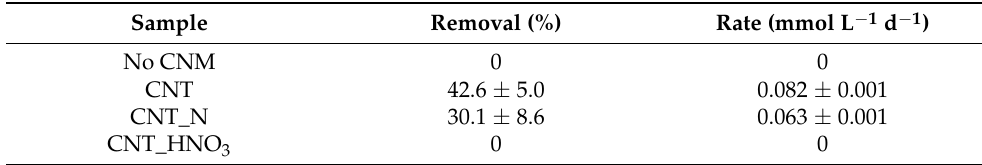
Table 2. Chemical reduction of ciprofloxacin (CIP) (1 mmol L − 1 ) by Na 2 S (1 mmol L − 1 ) in the absence and presence of the different